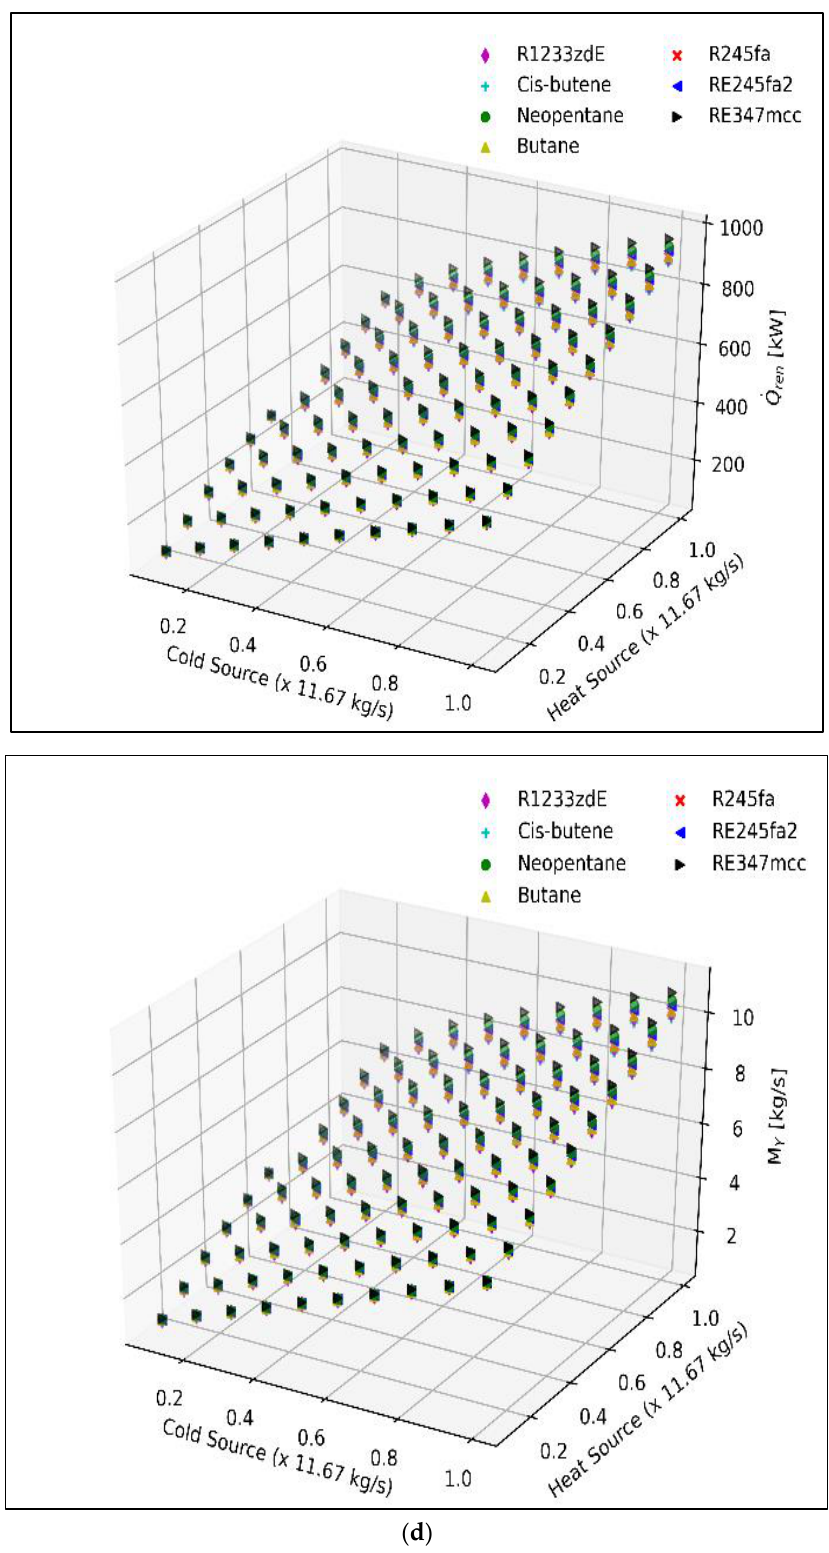
. Q ren , and M Y ( a ) at